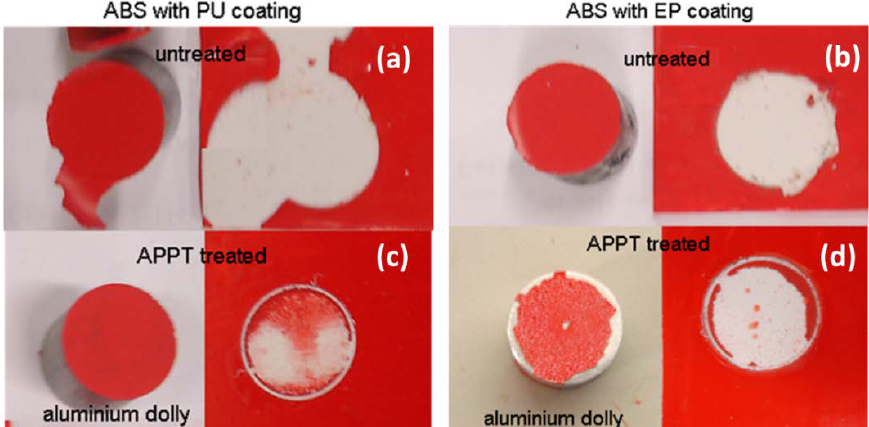
Figure 9. Adhesion pull-off tests: failure of untreated ABS with polyurethane ( a ) and epoxy ( b ) coatings, and treated ABS with PU ( c ) and EP ( d ).